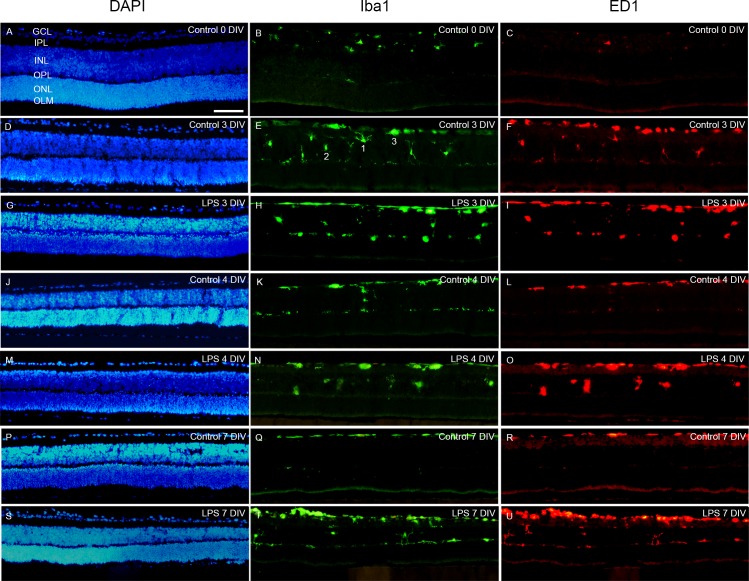
Iba1/ED1- fluorescent immunohistochemistry.Microglial cells were detected using the Iba1 (green) marker, expressed in all microglial stages and ED1 (red) for detecting activated cells. Cells were counterstained with the nuclei marker DAPI (blue). A-C. At 0 DIV, microglial cells were mainly found in the GCL, IPL and OPL, with a small fraction located in the GCL expressing ED1. At 3 and 4 DIV microglial cells were also found in the INL in both LPS-treated retinas and controls (D-F, G-I). At 3, 4 and 7 DIV the majority of the microglia expressed ED1 in both groups. At 7 DIV microglial cells were only found in the INL in the LPS-treated retinas (S-U cf. to P-R). Primarily three morphologies were found and used in the classification of activation stage, i.e. ramified (see cell #1 in E), round (see cell #2 in E) and amoeboid (see cell #3 in E). GCL = ganglion cell layer, INL = inner nuclear layer, IPL = inner plexiform layer, ONL = outer nuclear layer, NFL = nerve fibre layer, OLM = outer limiting membrane. Scale bar: 200 μm.